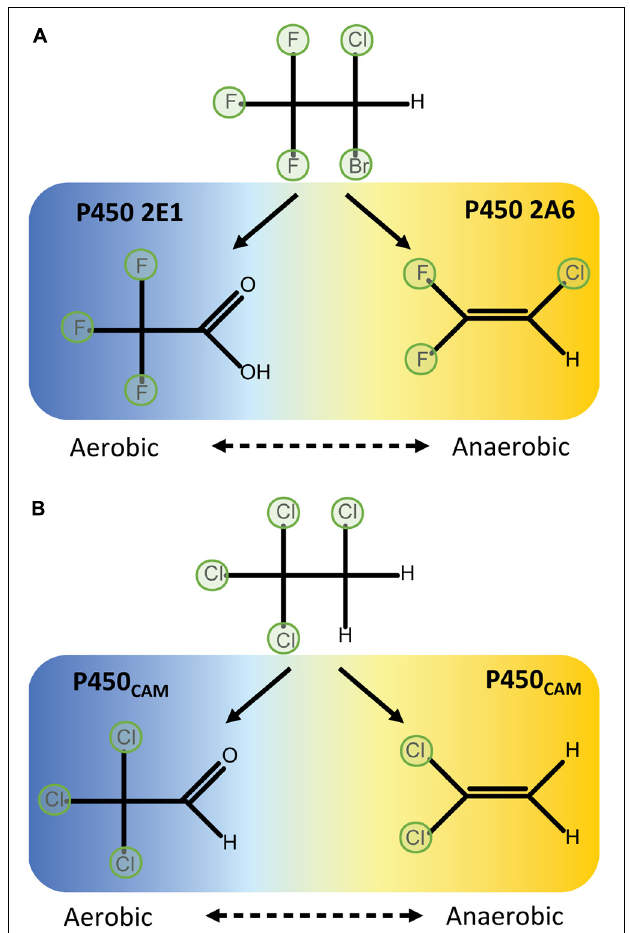
FIGURE 2 | Aerobic oxidative dehalogenation and anaerobic reductive dehalogenation by P450 enzymes. (A) In human liver microsomes, halothane is metabolised to difluoro-chloroethylene by P450 2A6 in hypoxic conditions or trifluoroacetic acid by P450 2E1 in aerobic conditions (Spracklin et al., 1996). (B) P450 CAM differentially metabolises 1,1,1,2-tetrachloroethane to either dichloroethylene in anaerobic conditions or trichloroacetaldehyde in aerobic conditions (Logan et al.,